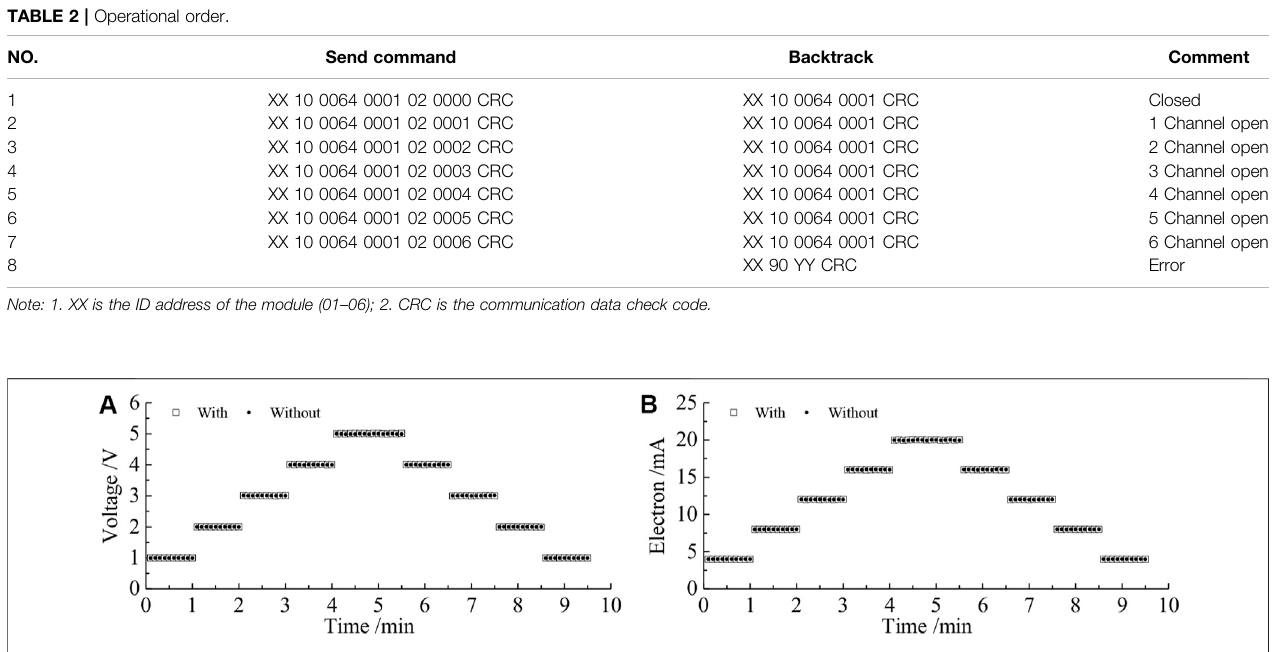
Frontiers in Earth Science |